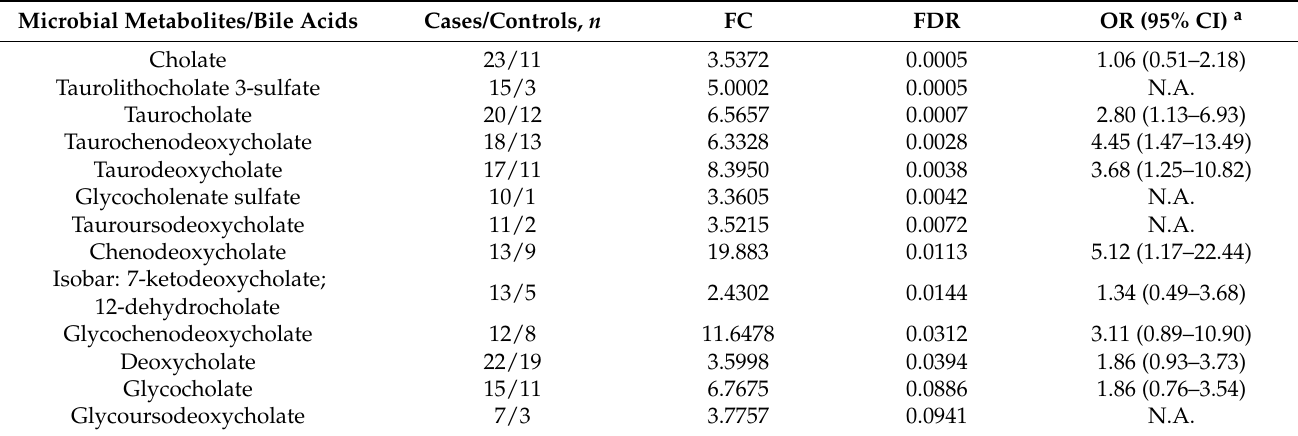
Table 5. Associations between significant bile acid concentration and colorectal adenomas, Diet and Health Study V, 2008–2010 (subset n = 50).